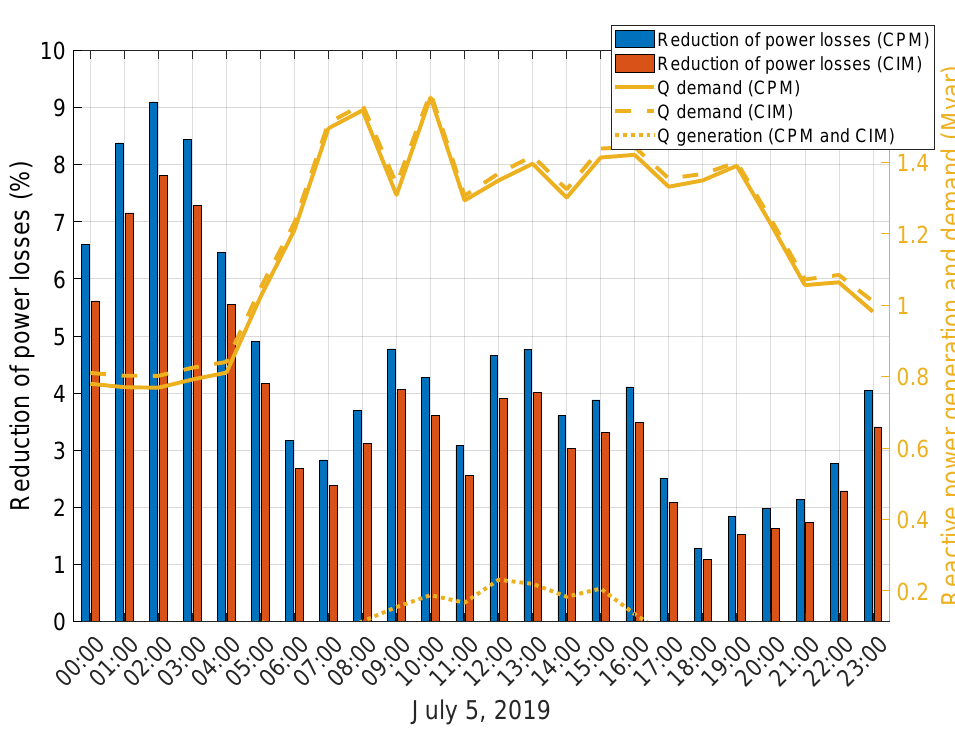
Figure 7. Reduction in power losses by optimal reactive power generation ( Case 1 ).